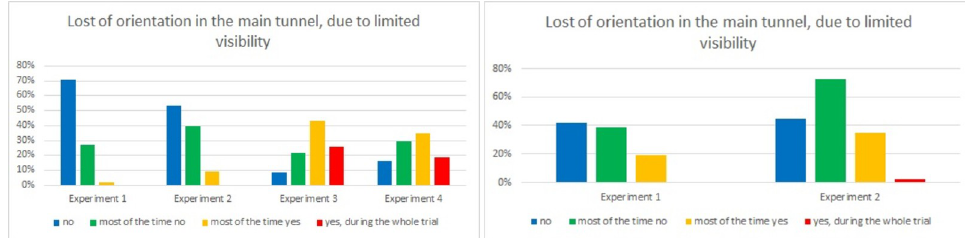
Fig 14. Problems with bearing, due to limited visibility—question 5. (Results from Laliki experiment are on the left side, from Gda ń sk on right).